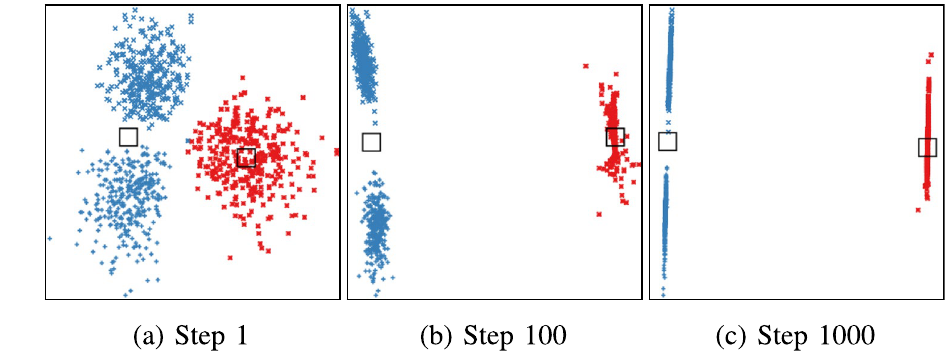
Fig. 3 The plots show the effect of the compression loss with projection as we use it in DeepECT. We can see that structures orthogonal to the two leaf node centers are preserved. (Colors represent leaf node assignments)